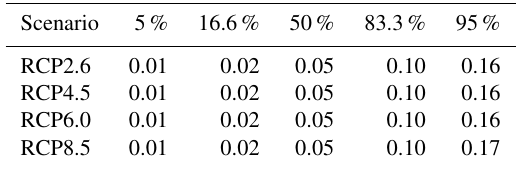
Figure 12. Projections from all models of the future sea level con- tribution of the Antarctic ice sheet under different atmospheric car- bon concentration scenarios following the procedure depicted in Fig. 1 and detailed in Sect. 2. The white line represents the median value, the dark shading the likely range (66th percentile around the median), and the light shading the very likely range (90th percentile around the median). Table 13. Sea level contributions from basal ice shelf melting from Antarctica until the middle of the 21st century (year 2050) from all models for the different emission scenarios in metres. The projec- tions are scenario independent until 2050, with the uncertainty of the forcing and across ice sheet models determining the uncertainty in the future.